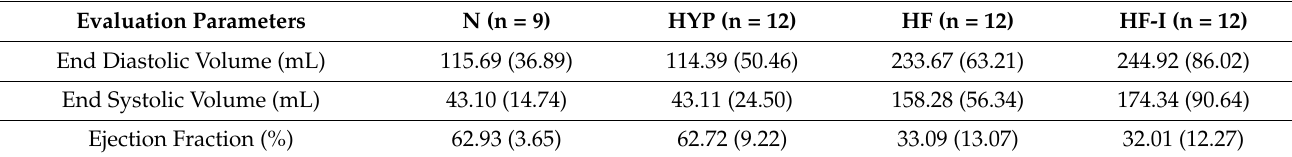
Table 2. Average statistics value based on pathological